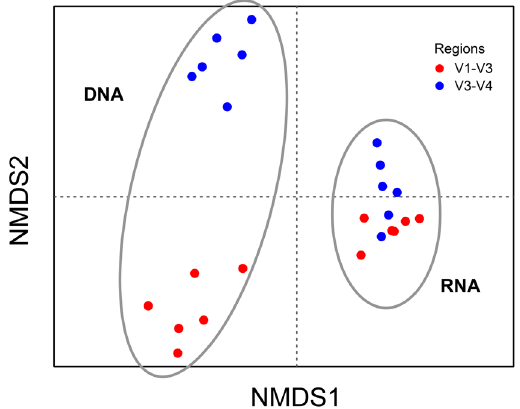
Figure 1. Non-metric multidimensional scaling plot (Bray-Curtis dissimilarity analysis) of the complete dataset (at genus level) including the six time points of sampling over a 24-h period, the different 16S rRNA regions analyzed and templates used (DNA versus RNA). Blue represents V3-V4 derived sequences and red represents V1-V3 derived